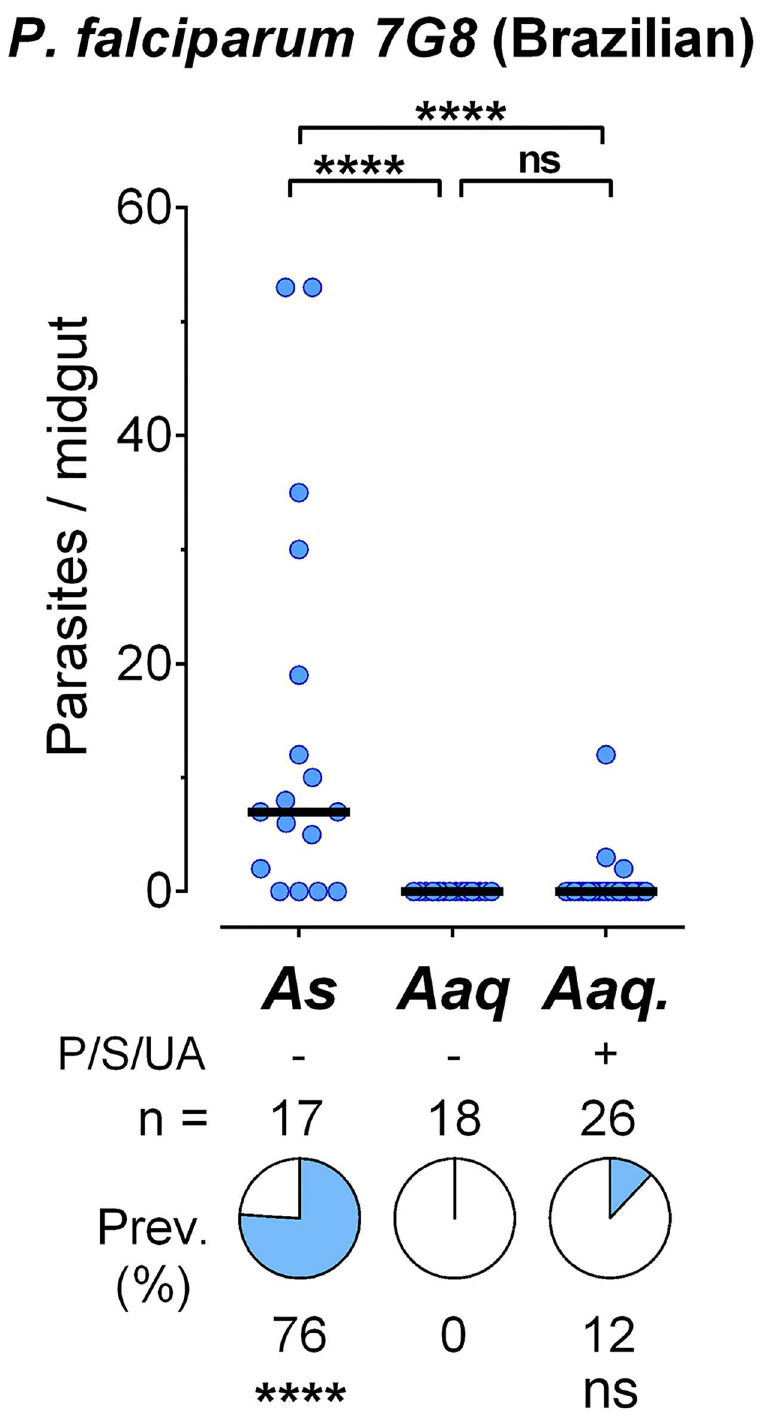
Fig 2. Infection of A . aquasalis with P . falciparum 7G8. Susceptibility of Anophelesstephensi (As) and Anophelesaquasalis (Aaq) mosquitoesto infection with Plasmodium falciparum 7G8 strain. The effect of oral administration of antibiotics (Penicillin/Streptomycin = P/S) and uric acid (UA) on Aaq infectionwas also tested. Each dot represents the number of oocysts present on an individual midgut 10–12days post-infection and the median numberof oocysts is indicatedby the black line. The medianswere comparedusing the Mann-Whitney test and the infection prevalence using Chi-square ( **** p < 0.0001).